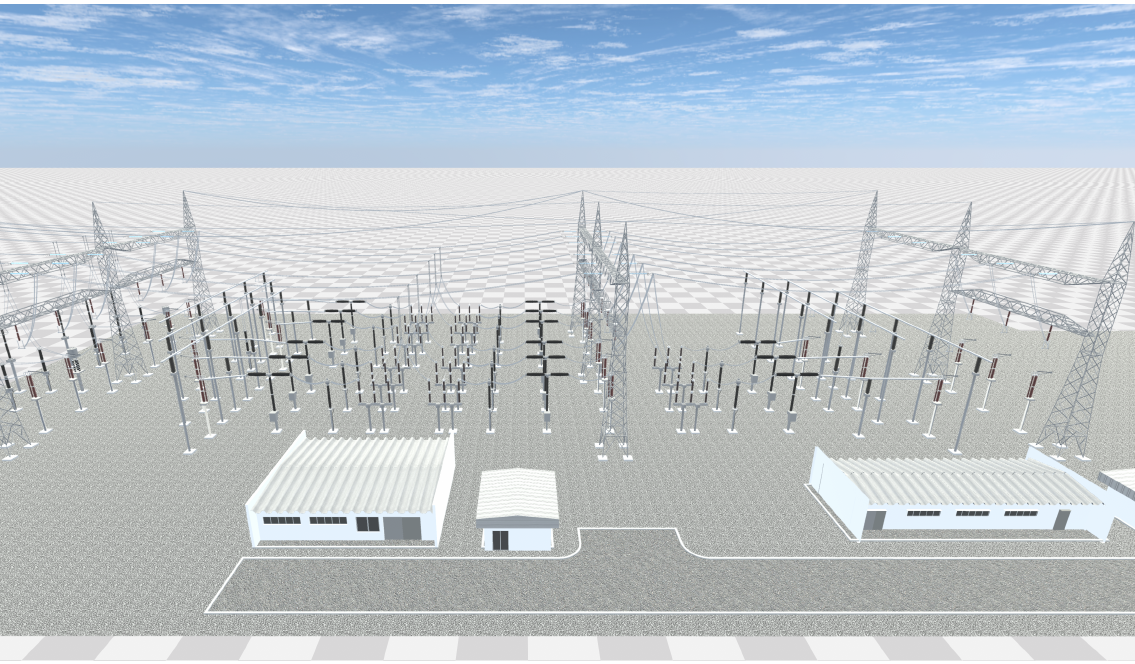
Figure 18. Virtual environment of the EPS run on the Virtual reality